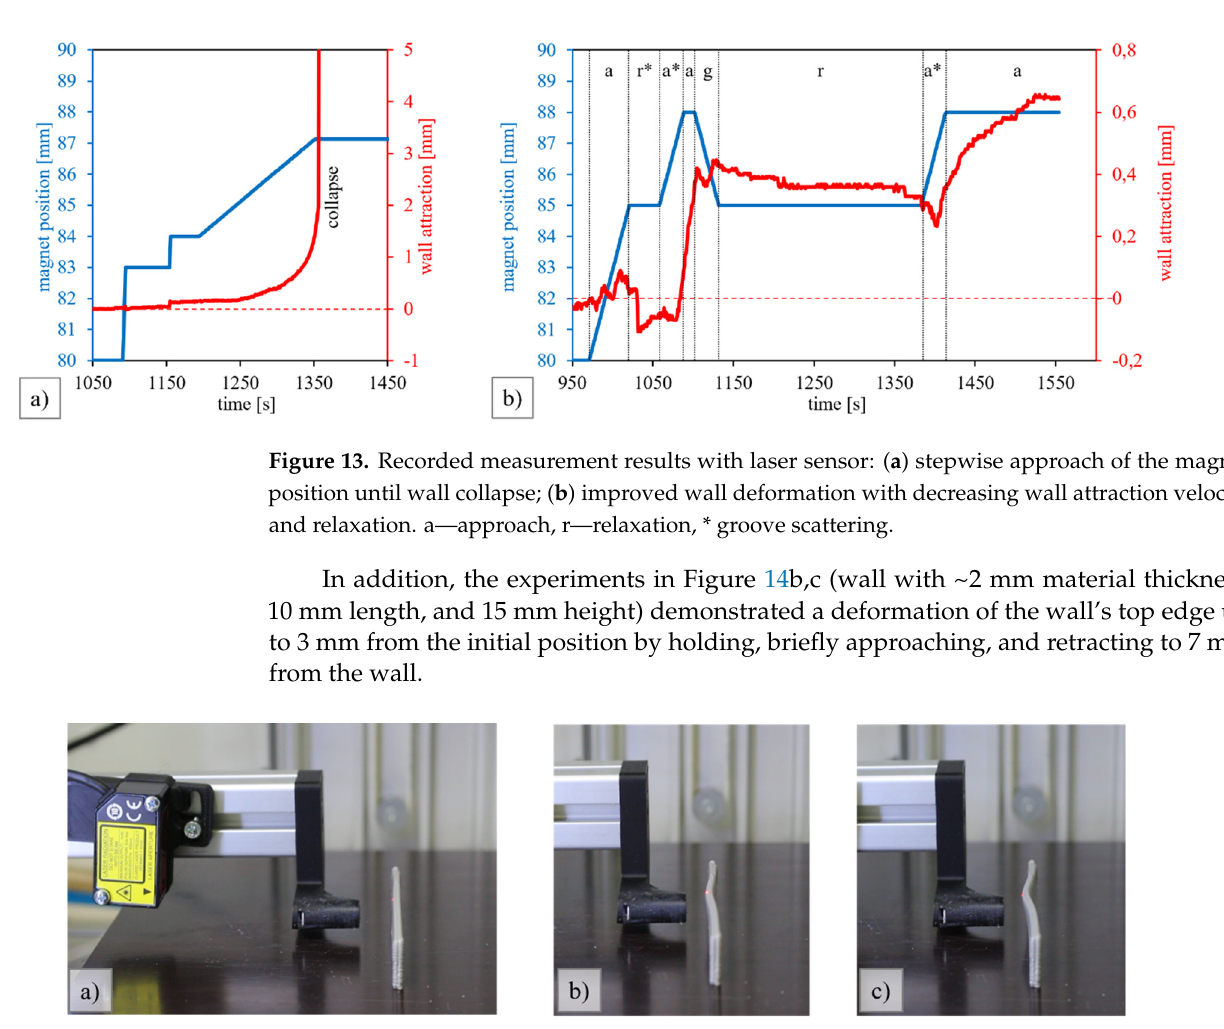
Figure 14. Deformation of the wall, measured with a laser sensor: ( a ) starting position 12 mm away from the wall; ( b ) slow approach to 8 mm and stop in front of the wall; ( c ) short jump to 7 mm and pull back to 8 mm.